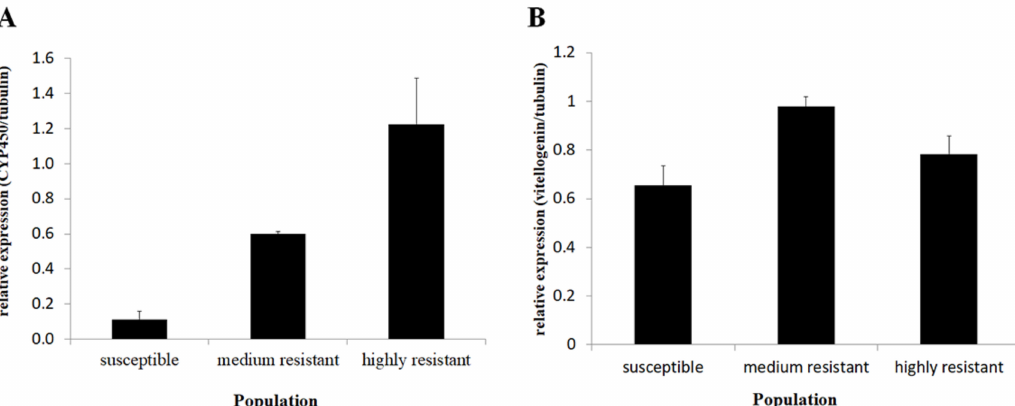
Figure 5. ( A ) Cytochrome P450 (CL844) relative expression levels in the three lab populations. The quantification was conducted using qRT-PCR (ANOVA, n = 4, df = 2, p = 0.002). ( B ) Relative expression levels of vitellogenin (CL1604) in the three thrip populations. Quantification was done using qRT-PCR (ANOVA, n = 4, df = 2, p =